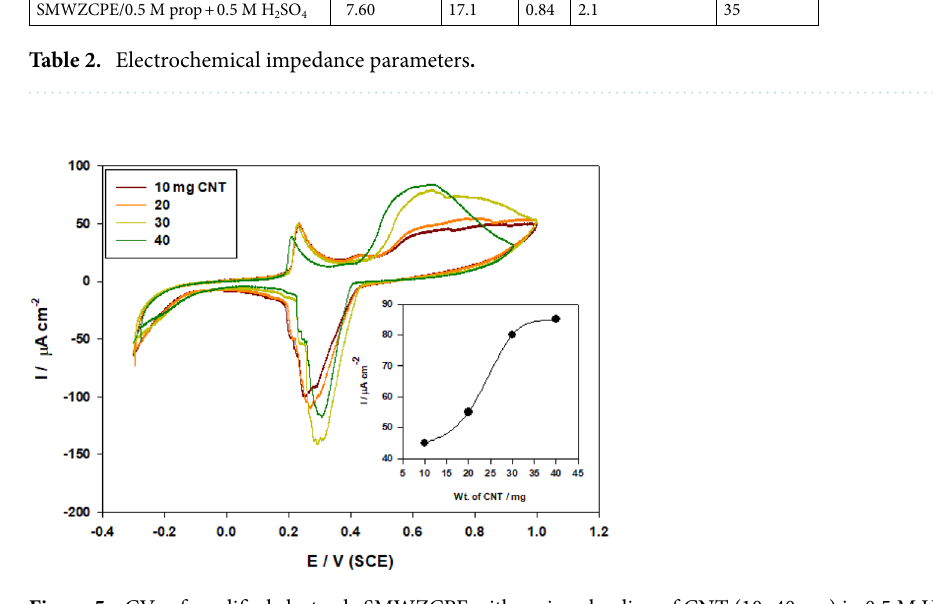
Figure 5. CVs of modified electrode SMWZCPE with various loading of CNT (10–40 mg) in 0.5 M H 2 SO 4 at scan rate of 100 mV·s -1